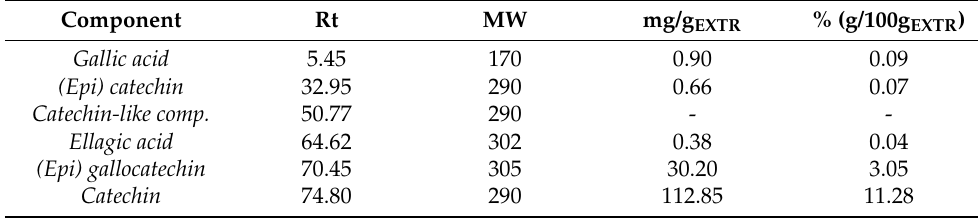
Table 4. Main components of chestnut optimized extract under subcritical